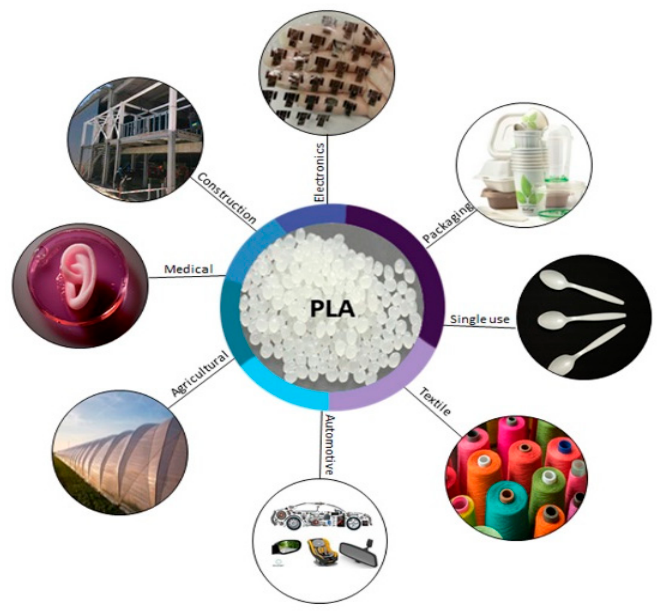
Figure 6. PLA applications in end-use industries and its’ global market consumption.